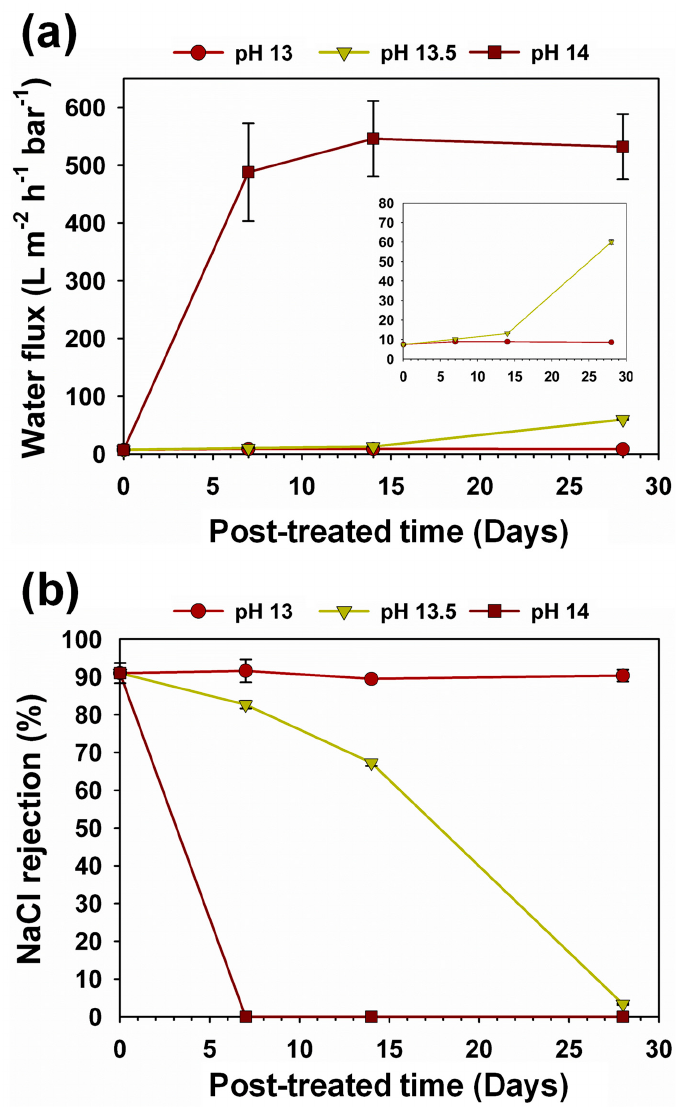
Figure 4. Effect of alkali hydrolysis on the permeability of NF 90 pristine and post-treated membranes in terms of ( a ) water flux and ( b ) NaCl rejection (experimental conditions: 2000 mg L − 1 NaCl and 5 bar).